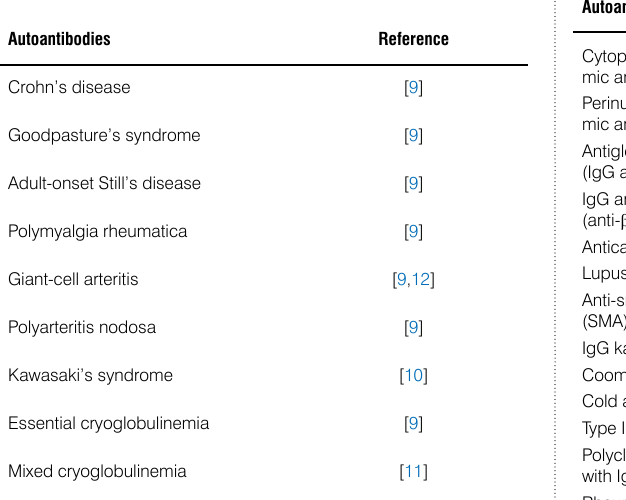
Table 2. Initial diagnoses in patients with Q fever who presented with signs and symptoms of